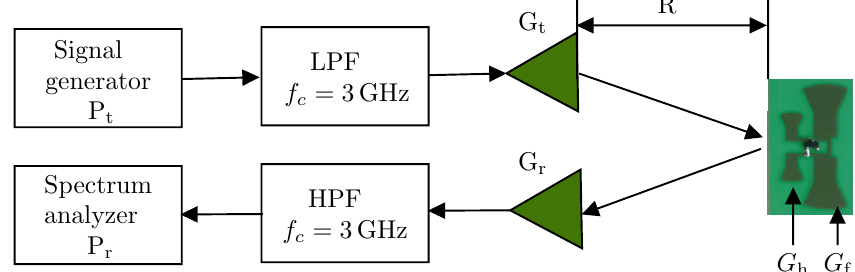
Figure 11. Link budget measurement